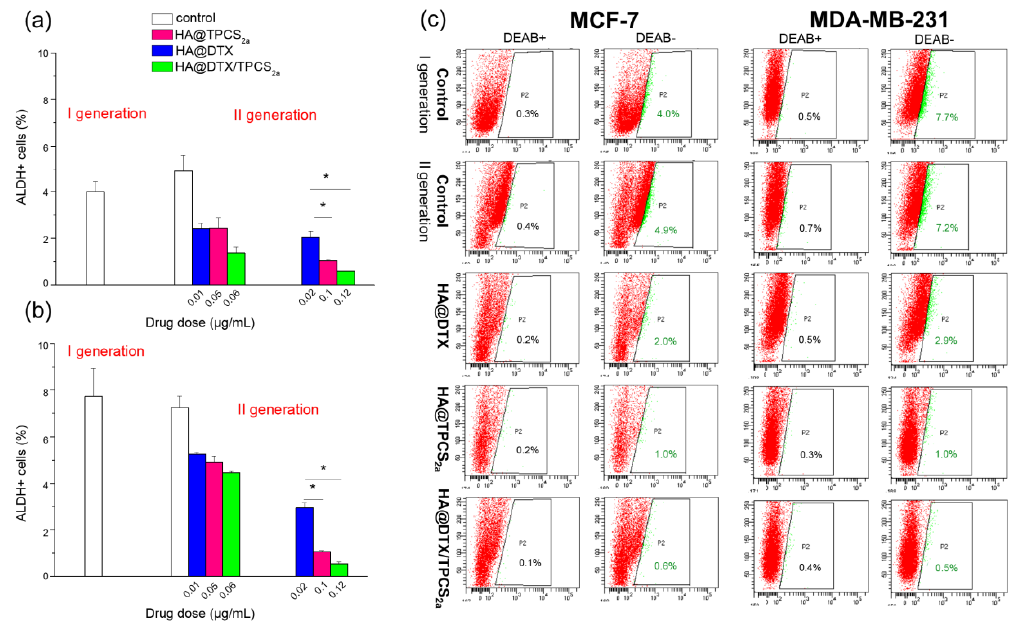
Figure 4. ALDEFLUOR assay in MCF-7 ( a ) and MDA-MB-231 ( b ) cells. Percentages of ALDH positive cells ( a , b ) and exemplificative flow cytometry plots ( c ) measured in first and second-generation mammospheres treated with drugs in HA-NPs. First generation mammospheres were incubated for 24 h with HA-NPs, irradiated with 1 J/cm 2 of red light and re-seeded in non-adherent conditions to allow formation of II-generation spheres. Seven (MCF-7) or 4 (MDA-MB-231) days after the reseed, the population of ALDH high cells was evaluated by gating the ALDH high cells, (green population and percentages) whose fluorescence in flow cytometry plots (DEAB − ) exceeded that of the negative controls (DEAB+) stained with the ALDH inhibitor DEAB to control background fluorescence. Flow cytometry plots are referred to mammospheres treated with drug doses of 0.02 μg/mL DTX, 0.1 μg/mL TPCS 2a , 0.12 μg/mL DTX + TPCS 2a . Data are expressed as mean ± S.D. of at least two